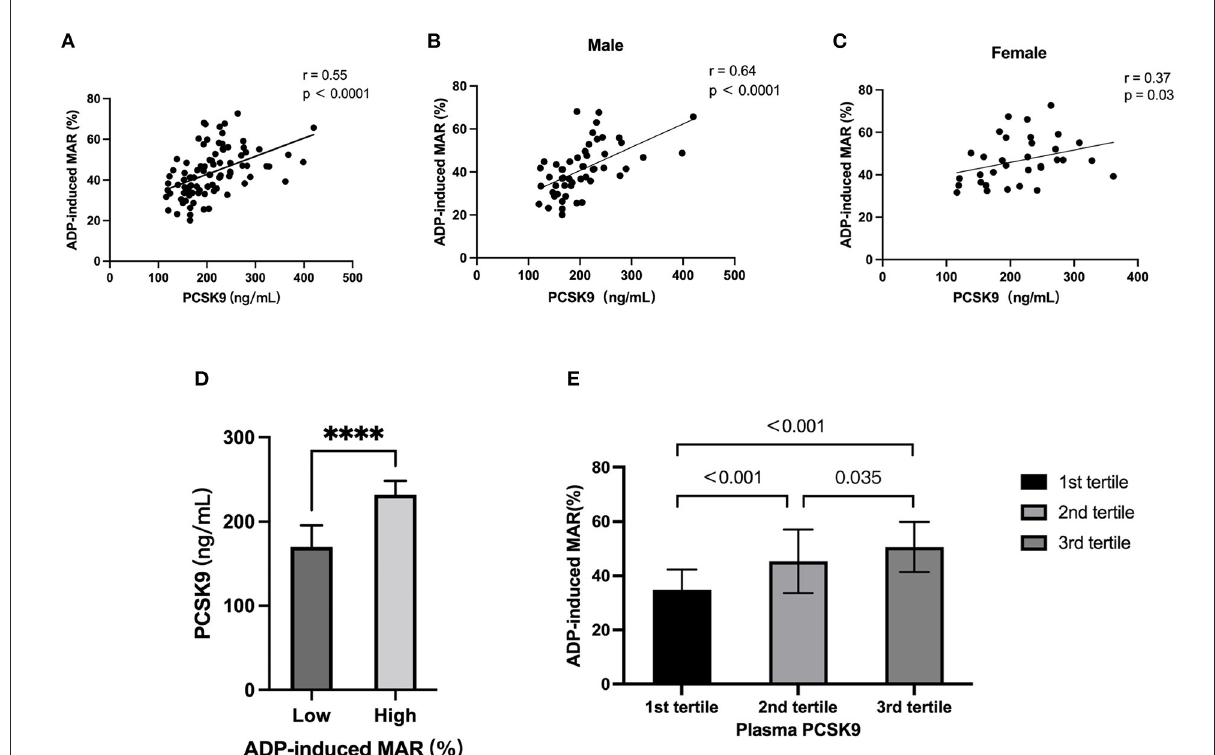
FIGURE5 Association between proprotein convertase subtilisin/kexin type 9 (PCSK9) levels and ADP-induced platelet maximal aggregation rate (MAR). (A) Univariate linear correlation analysis of serum PCSK9 with ADP-induced MAR. (B,C) The correlation of serum PCSK9 with ADP-induced MAR was stratified by sex. (D) Comparison of ADP-induced MAR in subject with different PCSK9 according to tertile value. (E) Comparison of serum PCSK9 in subjects with ADP-induced MAR lower and higher than mean value. ****: P < 0.0001.